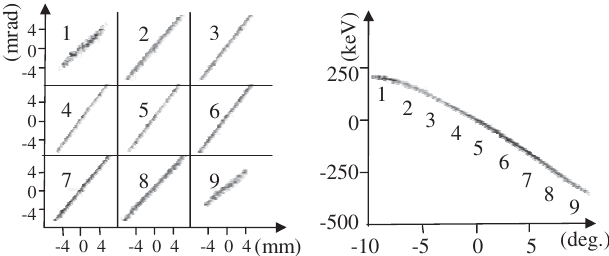
FIG. 8. (Color) Transverse slice phase-spaces (left) and longitu- dinal slice phase-space (right) at the gun’s exit in the example (cid:2) 60 (cid:11) . Slice #1 is the front slice discussed in Sec. VI with (cid:9) 0 and slice #9 is the rear one.